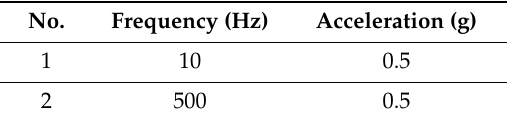
Table 2. Test profile for harmonic excitation.